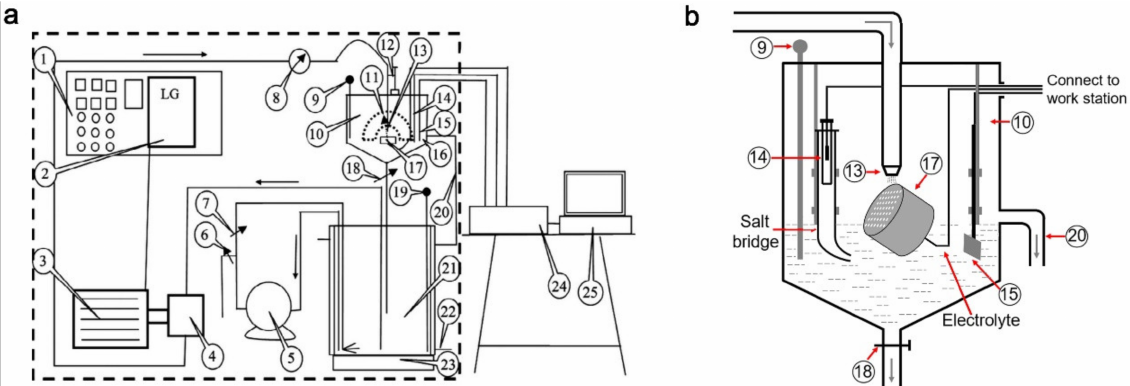
Figure 2. ( a ) Schematic diagram of the jet impingement apparatus for the erosion–corrosion test and ( b ) the enlarged sample chamber: ( 1 ) control cabinet, ( 2 ) frequency converter, ( 3 ) motor, ( 4 ) lobu- lar pump, ( 5 ) stirring pump, ( 6 , 7 ) valves, ( 8 ) screw elevator, ( 9 ) thermocouple I, ( 10 ) impingement cabinet, ( 11 ) impingement angle meter, ( 12 ) electromagnetic flowmeter, ( 13 ) nozzle, ( 14 ) reference electrode, ( 15 ) counter electrode, ( 16 ) pH meter probe, ( 17 ) wire beam electrode (working electrode), ( 18 ) valve, ( 19 ) thermocouple II, ( 20 ) overflow tube, ( 21 ) slurry container, ( 22 ) cooling water, ( 23 ) heater, ( 24 ) electrochemical workstation and ( 25 )